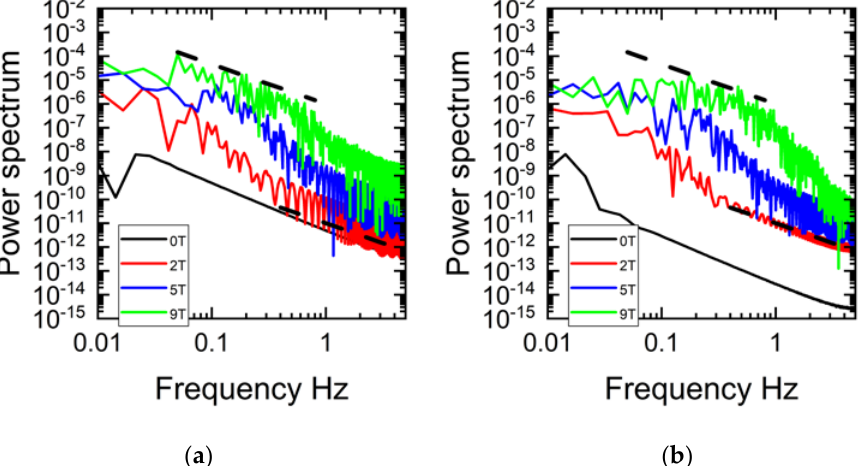
Figure 14. Fast Fourier transform results for the velocity components u ( a ) and v ( b ) for the case with ΔT = 11 °C.